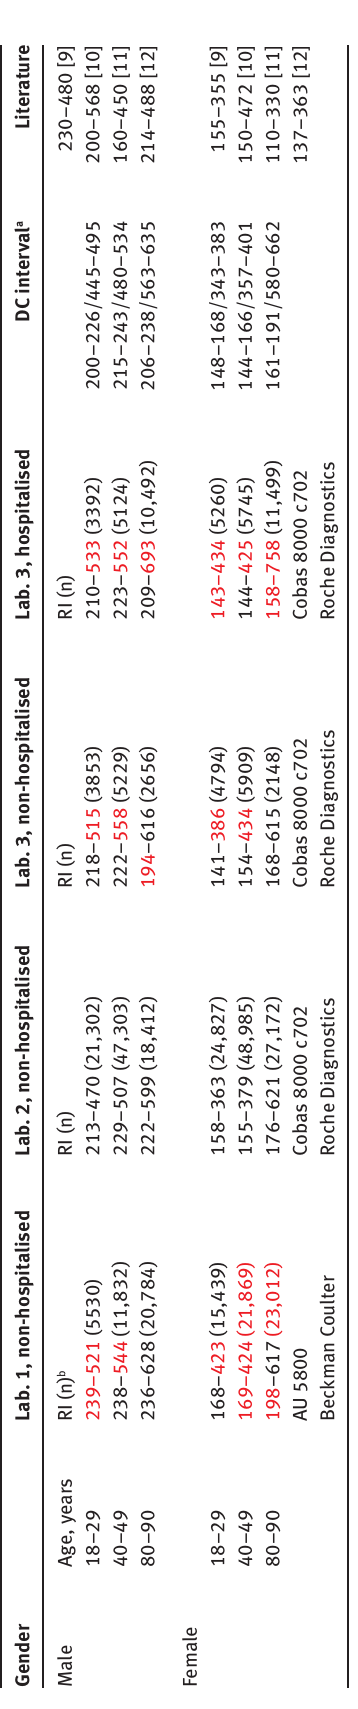
(Figure 1). The upper RLs (97.5 th percentile) in